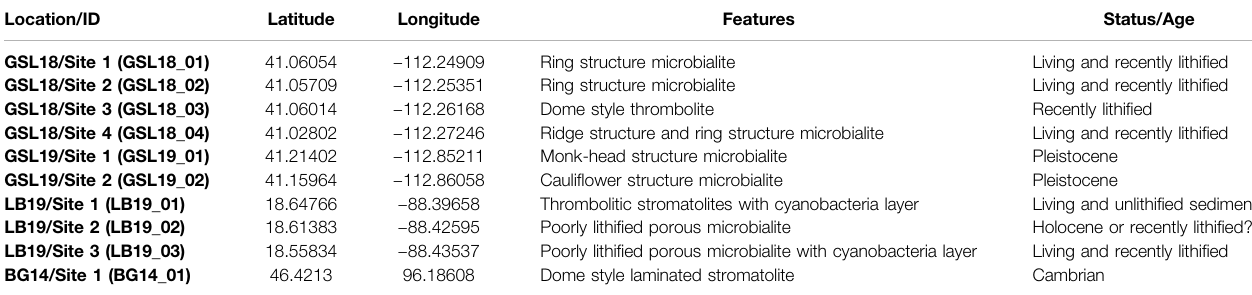
TABLE 1 | Microbialite sample locations and